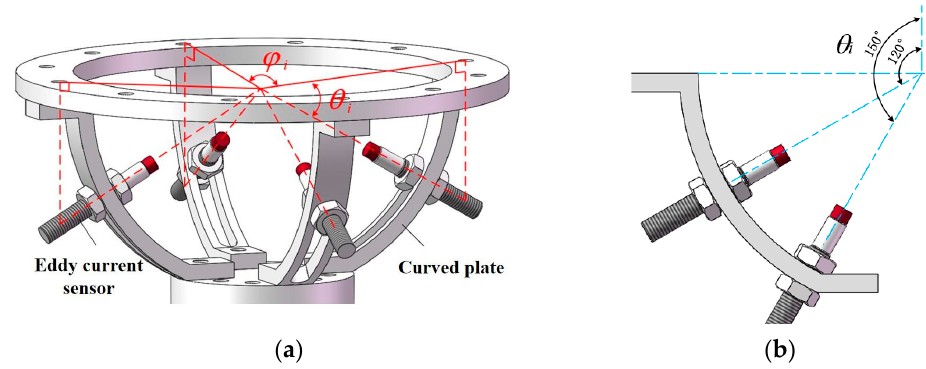
Figure 3. ( a ) The position of the eddy current sensor array; ( b ) the range of the eddy current sensor.